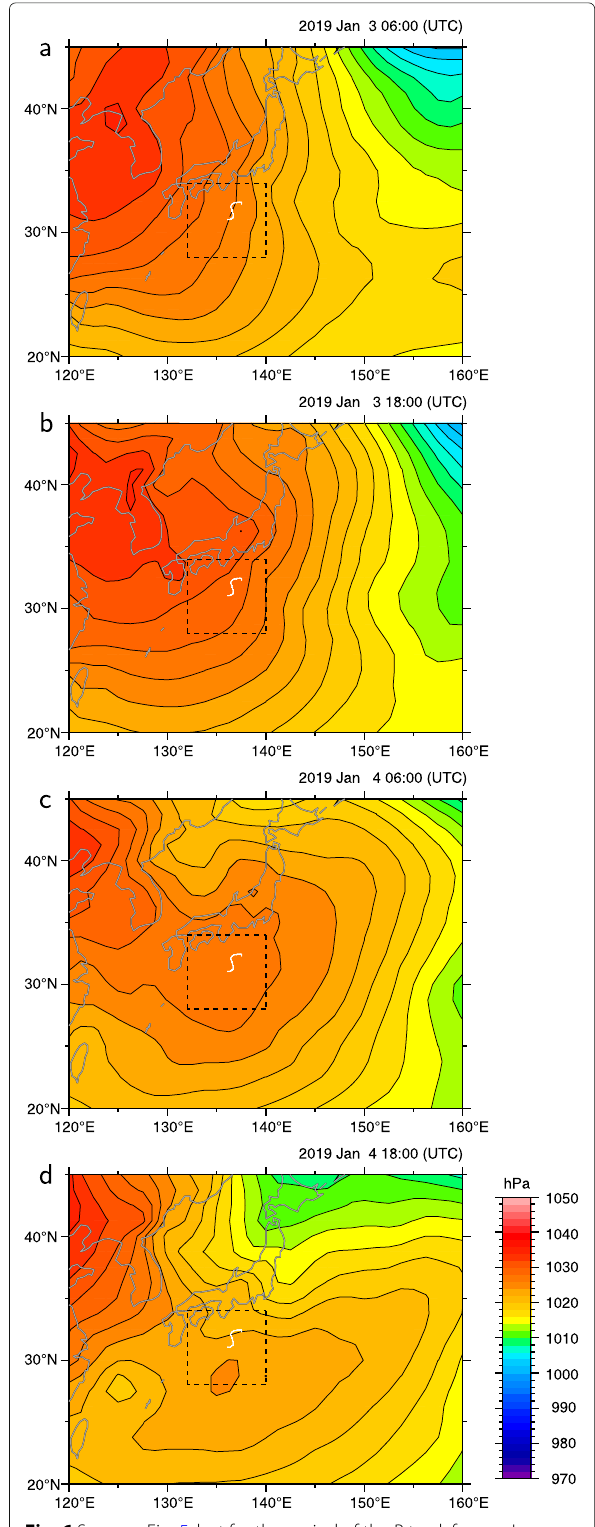
Fig. 6 Same as Fig. 5, but for the period of the B track from a January 3 06:00, 2019, to d January 4 18:00, 2019